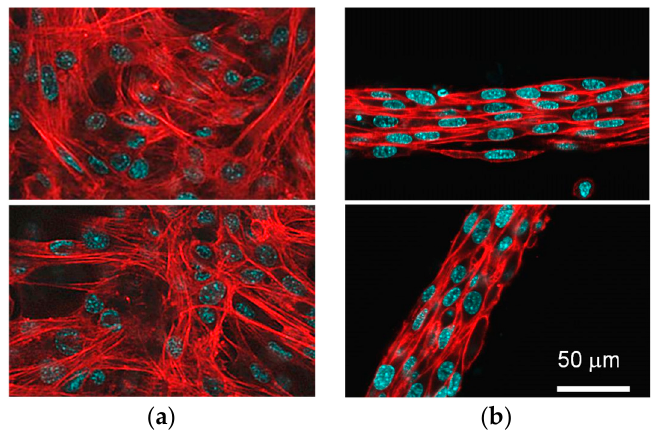
Figure 4. Fluorescent images of rhodamine-phalloidine/DAPI counterstaining to visualize the actin cytoskeleton of the C2C12 cells. ( a ) Monolayer culture and ( b ) three-dimensional culture using a hydrogel microfiber culture of the C2C12 cells. Scale bar: 50 μ m.